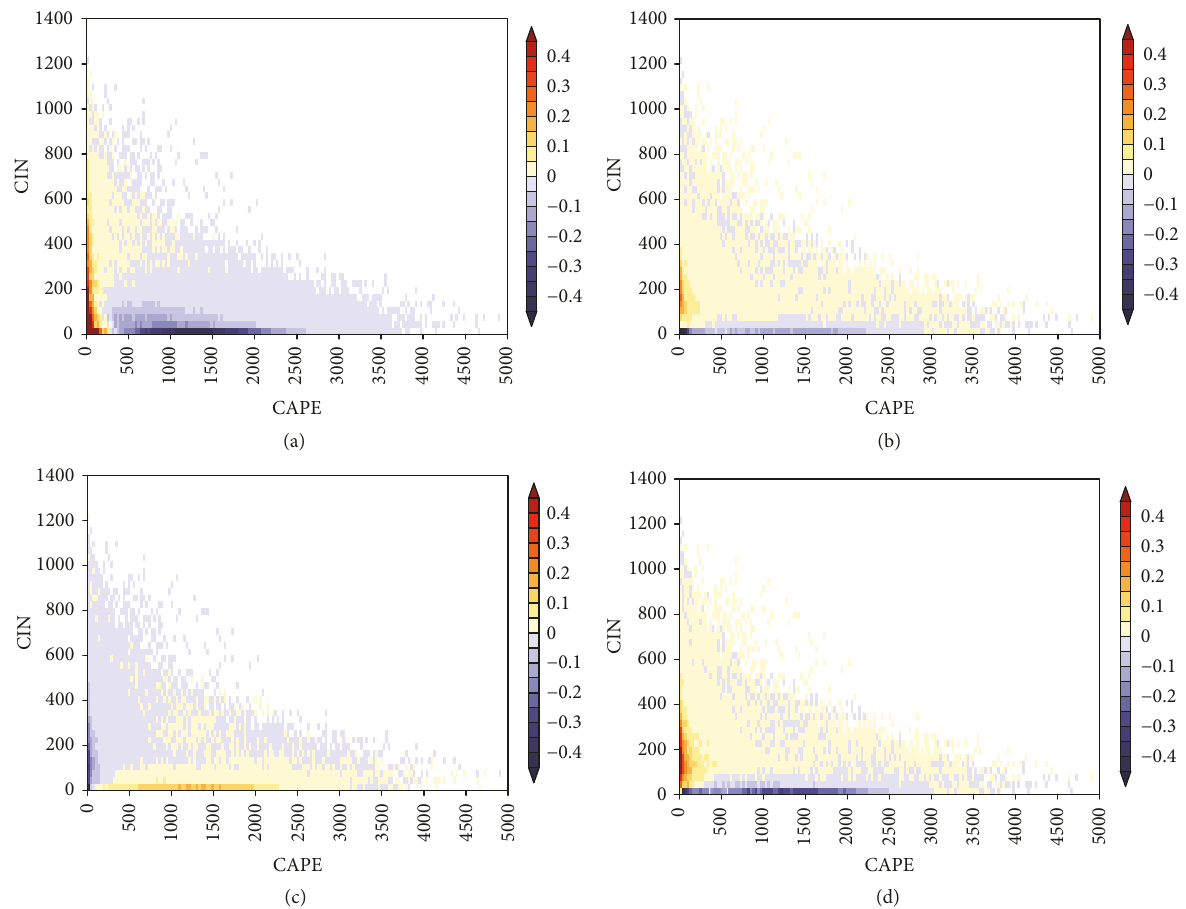
Figure 1:Anomalous jointprobability density functionsof CAPEand CINbased on 3-hourly MERRAreanalysis for(a) pre-Changma period, (b) the period during Changma, and (c) post-Changma period, and (d) difference between (b) and (c). Anomalies are calculated based on summer mean